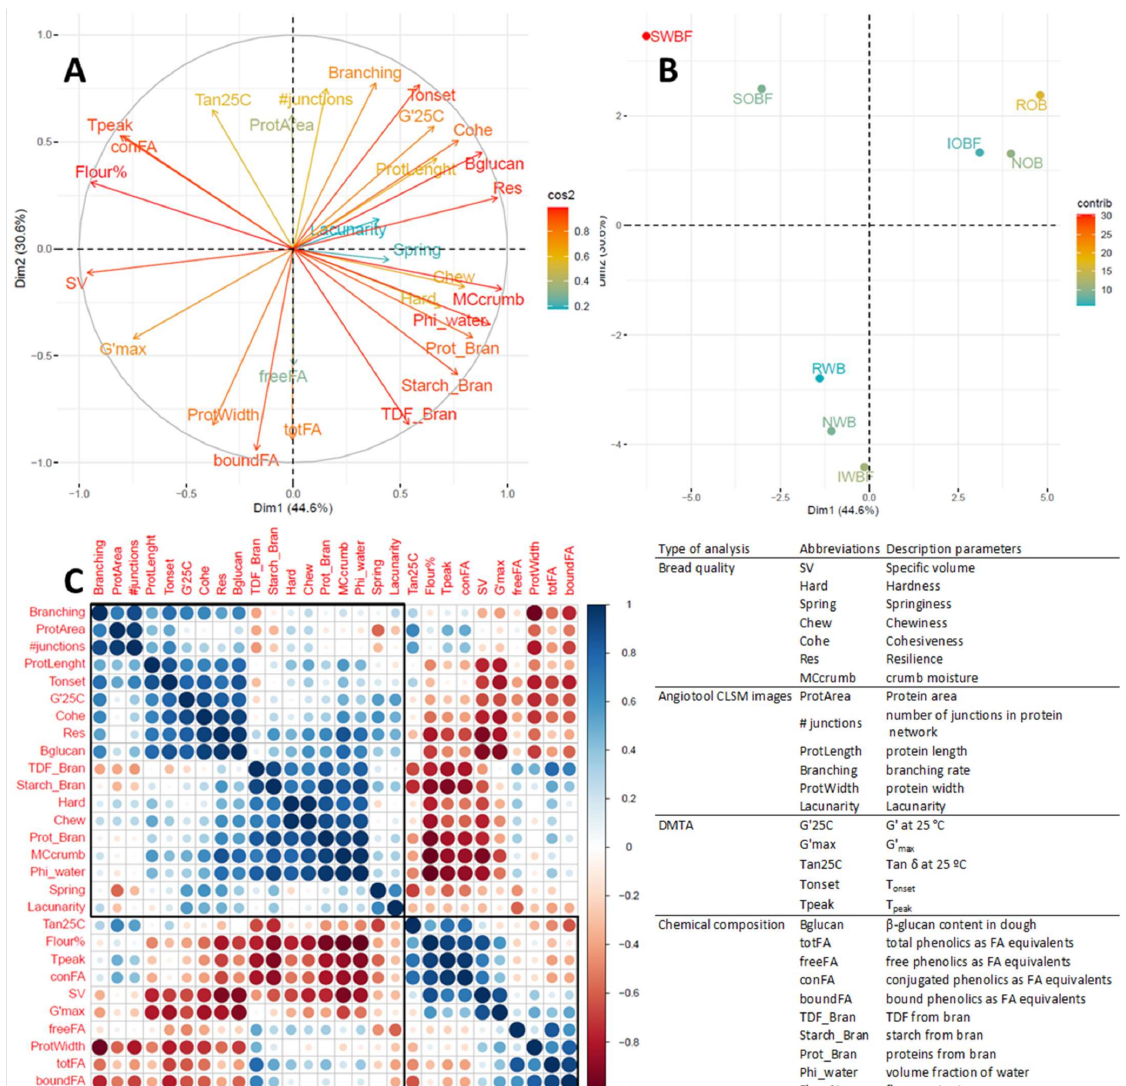
Figure 7. PCA analysis with loading plot of chemical, rheological, microstructural, and bread quality parameters ( A ) and samples score plot ( B ). Map of correlations analysis between the different parameters ( C ). The table provides information on the type of analysis, abbreviation, and description for each parameter. Additional details for protein network parameters are provided in [31]. Sample abbreviations are reported in Table